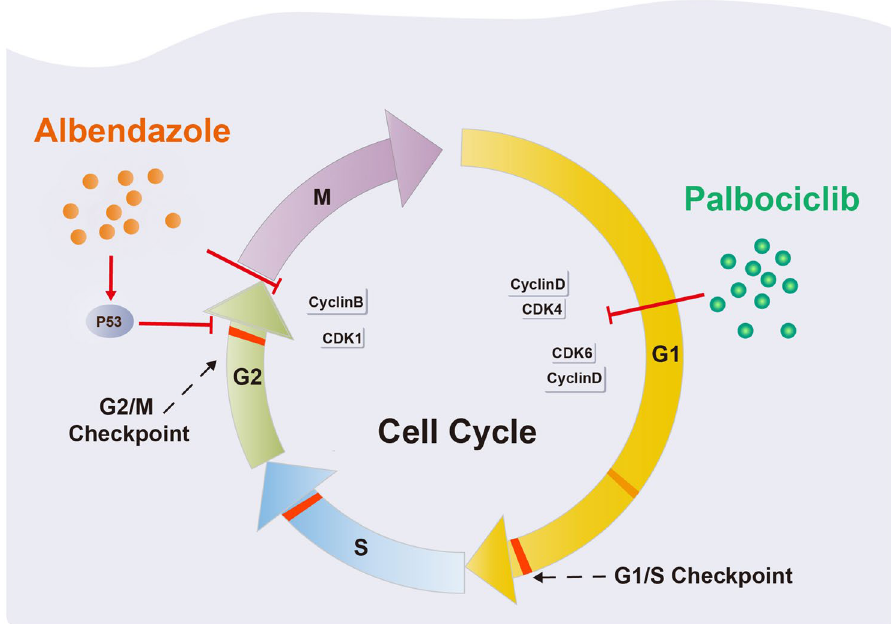
Figure 5. Schematic presentation of the Albendazole plus palbociclib synergistically suppresses melanoma cell growth by arresting the cell